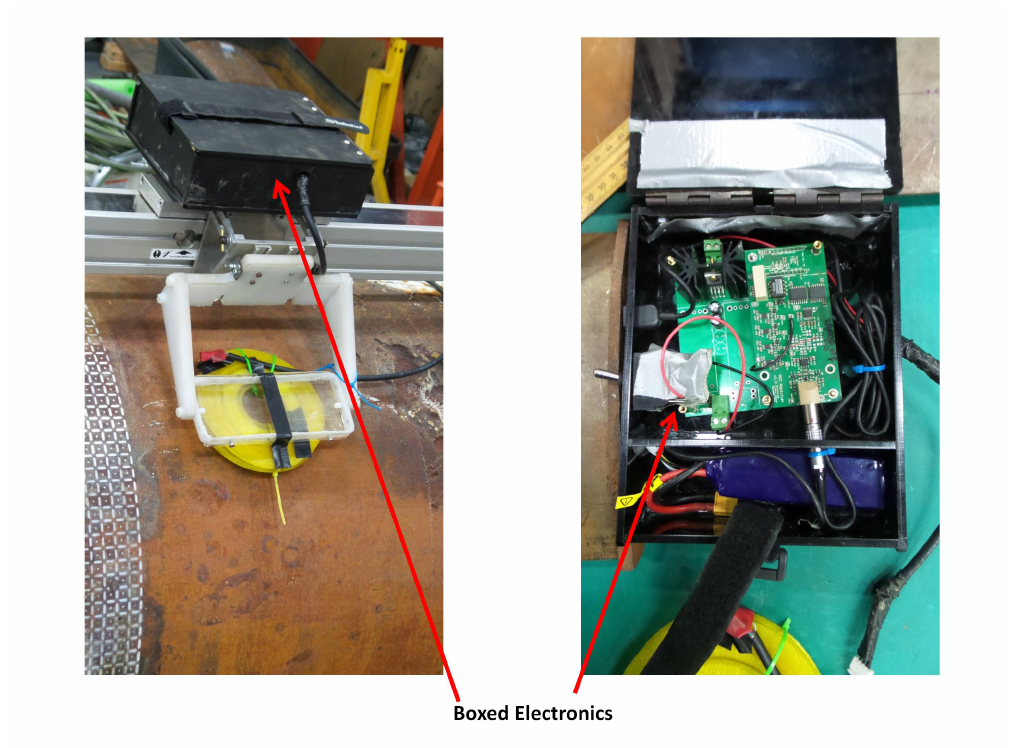
Figure 11. Sensing setup performing an external pipe